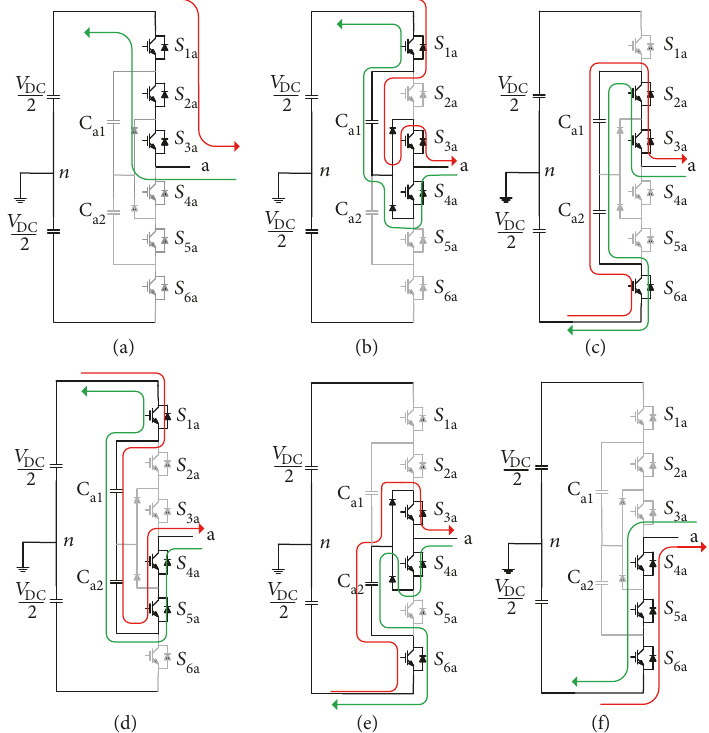
Figure 2: Six switching states of NNPC inverter: (a) switching state 3; (b) switching state 2A; (c) switching state 2B; (d) switching state 1A; (e) switching state 1B; and (f) switching state 0.